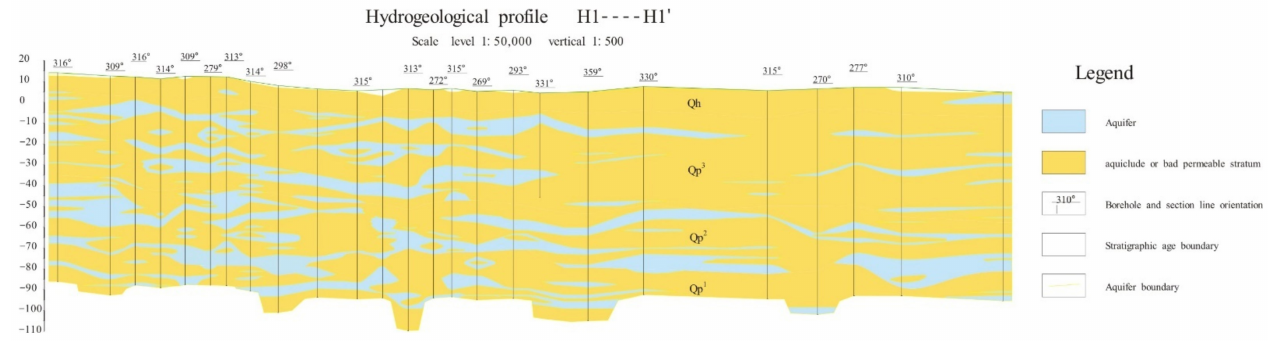
Figure 5. Hydrogeological profile in Xiong’an New Area H1——–H1 (cid:48)